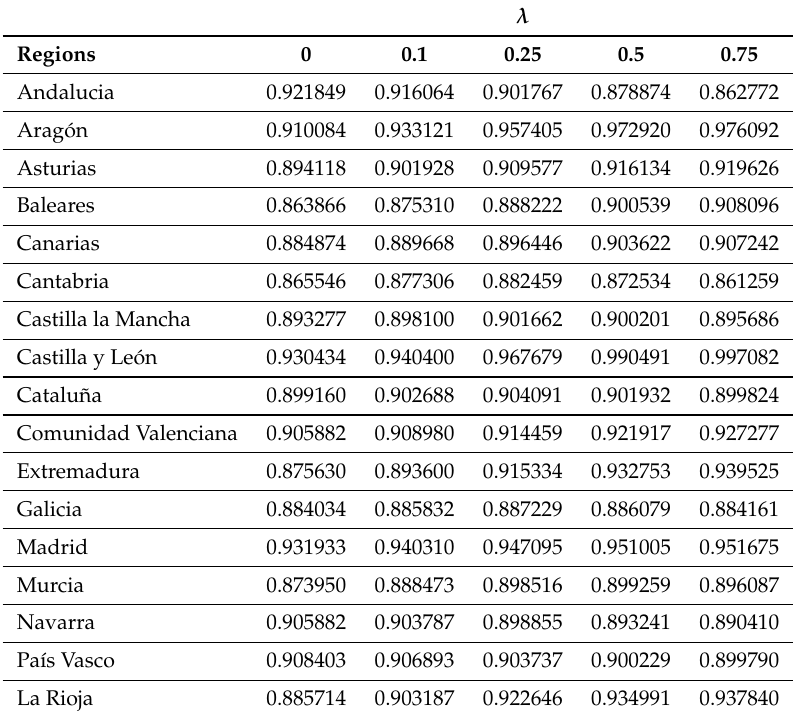
Figure A8. Graphic illustration of the global preferences stability measures for Spaniards from different values of λ for Questions 1 and 2. Table A8. Global stability measures for Spaniards’ preferences attending to different regions and several values of λ for Question